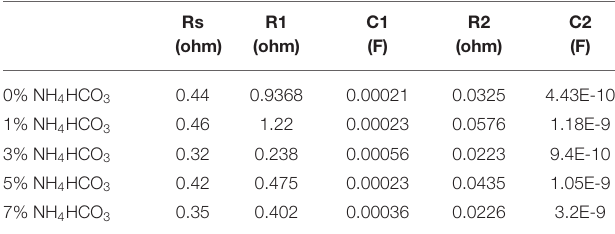
TABLE 1 | EIS simulation results for the